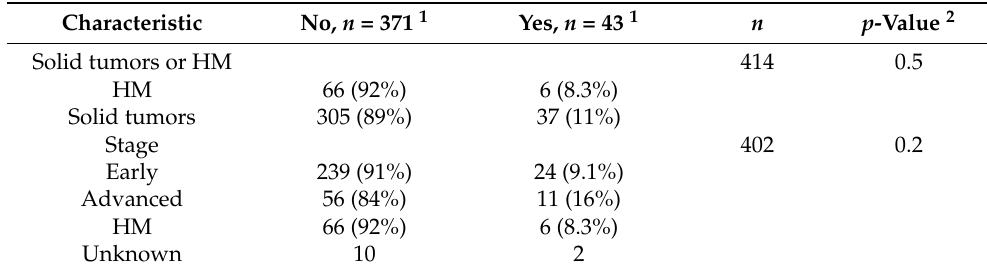
Table 2. Clotting events in solid tumors vs. hematological